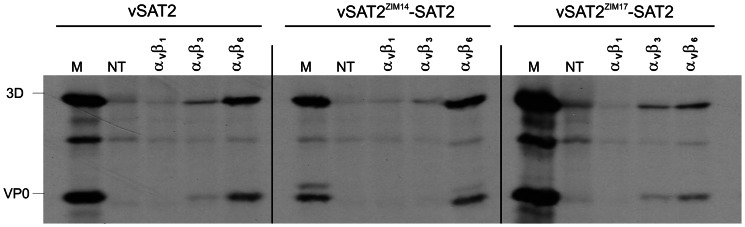
COS-1 cells were co-transfected with cDNA plasmids encoding the bovine integrin αV subunit and either the β1, β3 or β6 subunits.Transfected cells were infected with the recombinant SAT2 viruses and proteins were radiolabelled with [35S]methionine. Viral protein synthesis were analyzed by radiolabelled immune-precipitation and SDS-PAGE. Immune-precipitated proteins from non-transfected but infected cell-lysates are indicated by “NT”, and the location of the viral structural proteins from lysates prepared from FMDV-infected BHK-21 cells is indicated by “M”.